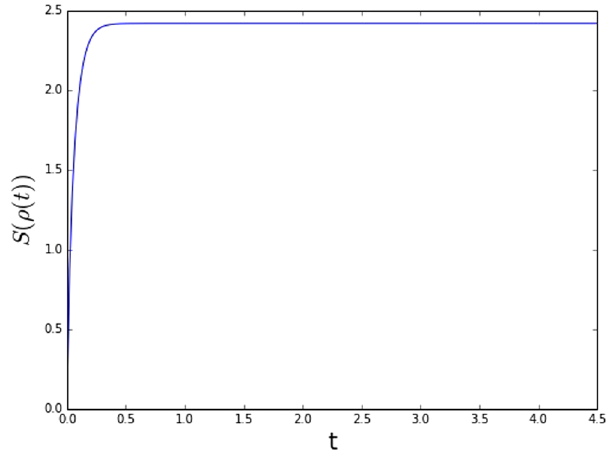
Figure 1. The evolution of network entropy for classical network dynamics.